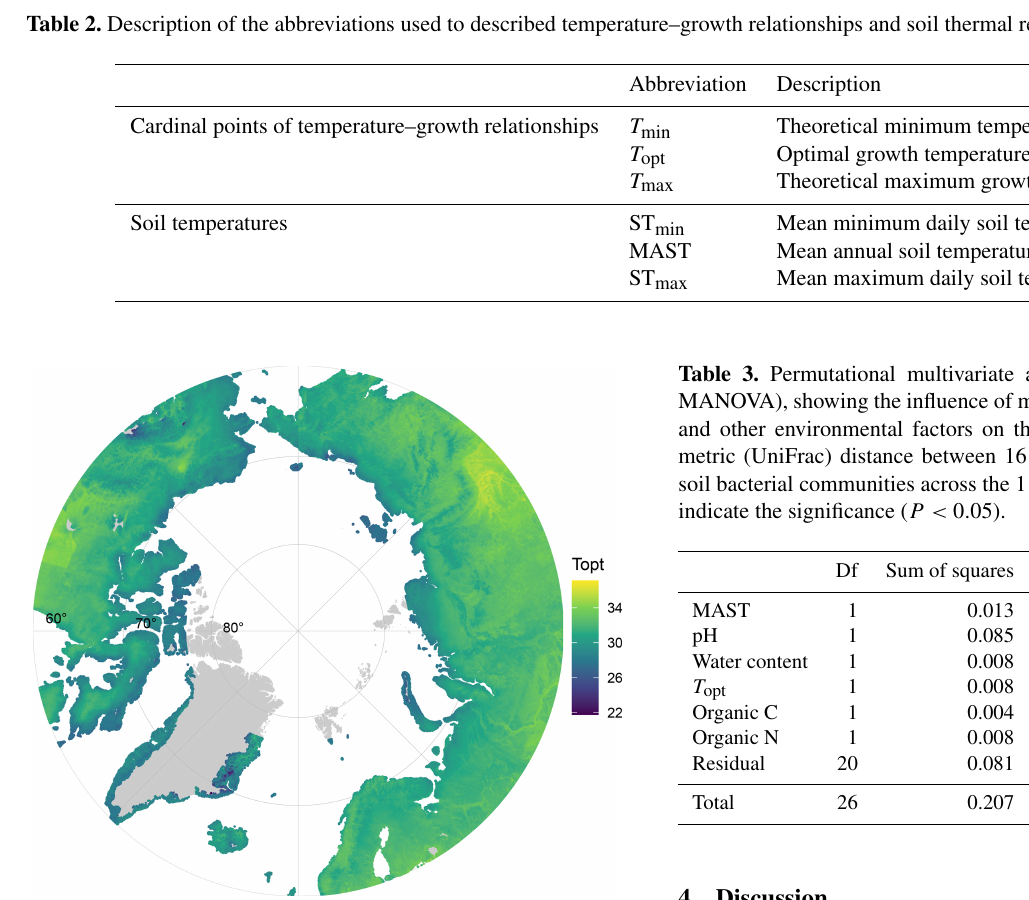
Figure 4. Map of the predicted T opt of soil bacterial communities across the Arctic, based on the linear relationship between maxi- mum soil temperature (from SoilTemp database) and T opt .